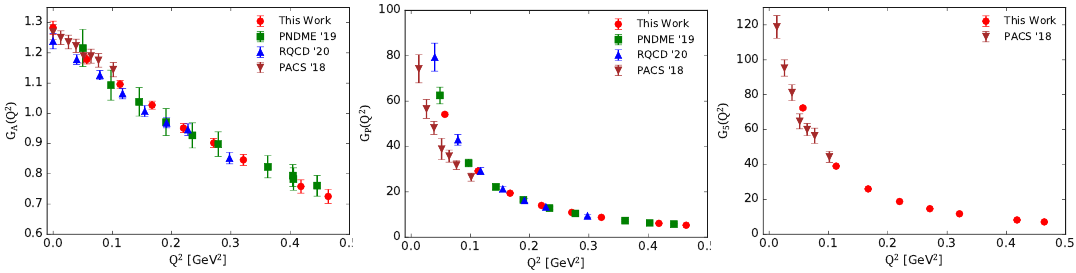
( Q 2 ) (left), G ( Q 2 ) (middle) A P